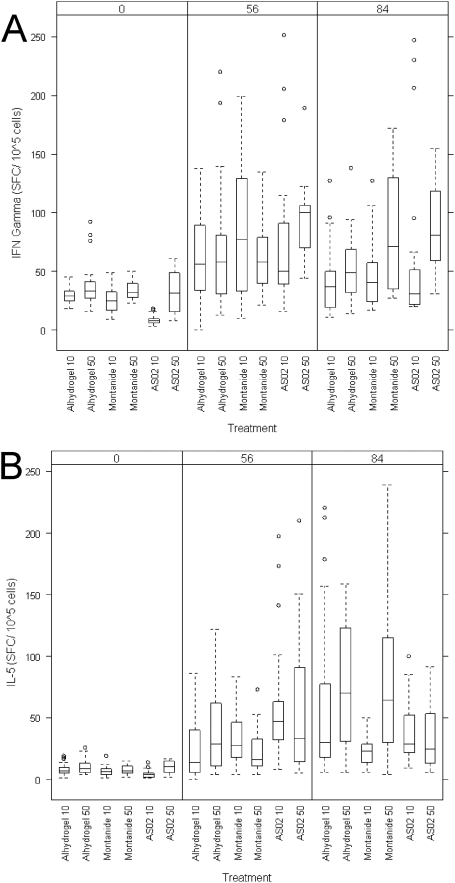
ELISPOT assay for IFNγ (A) and IL-5 (B) after stimulation with 6 µg PfAMA1.Peripheral Blood Mononuclear Cells from immunised volunteers 28 days after the second immunisation and 28 days after the third immunisation (day 56 and 84 respectively) were stimulated with 6 µg of PfAMA1 vaccine. Production of IFNγ and IL-5 was measured by counting spots in ELISPOT plates. Box plots and whiskers show the range and the 25th, 50th and 75th percentile of spots per 2×105 cells. Circles represent outliers.